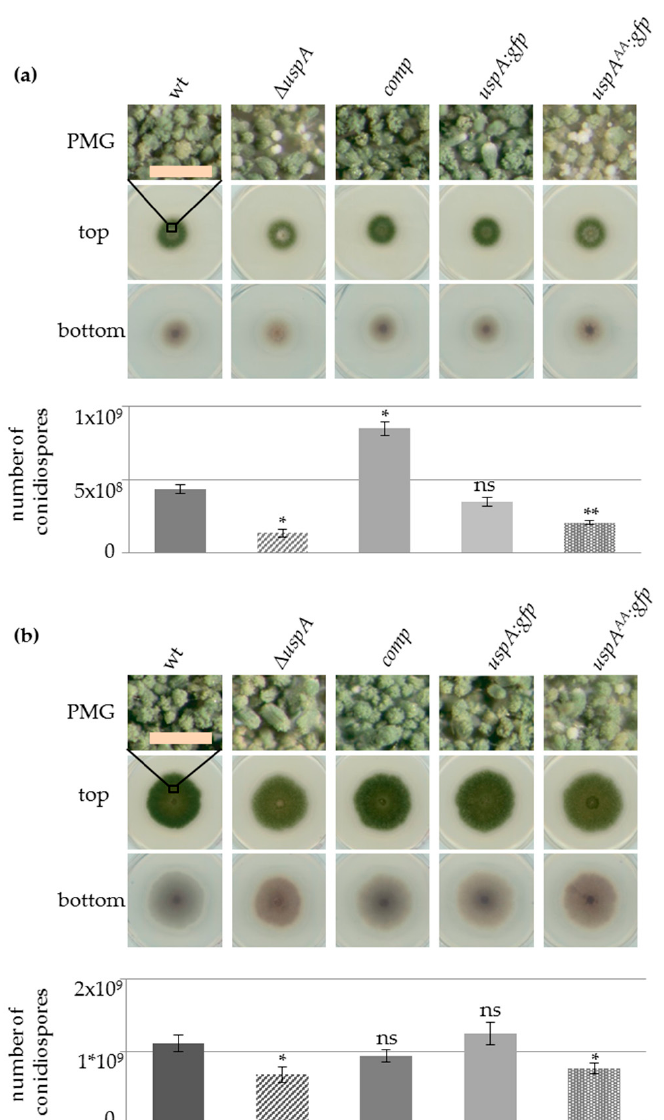
Figure 5. UspA accelerates the formation of conidiospores. 5000 spores were point-inoculated on minimal medium and incubated for three days ( a ) or five days ( b ) at 37 ◦ C in light. A photomicrograph (PMG) of the highlighted region (black square), as well as the top and bottom of the colonies, are shown (comp: ectopic expression of uspA in ∆ uspA ). The error represents the standard error of the mean of three biological replicates with two technical replicates each. Significances against wild type (wt) number of spores were calculated with t -test (** p ≤ 0.01, * p ≤ 0.05, ns – not significant). The scale bar in the PMG represents 200 µ